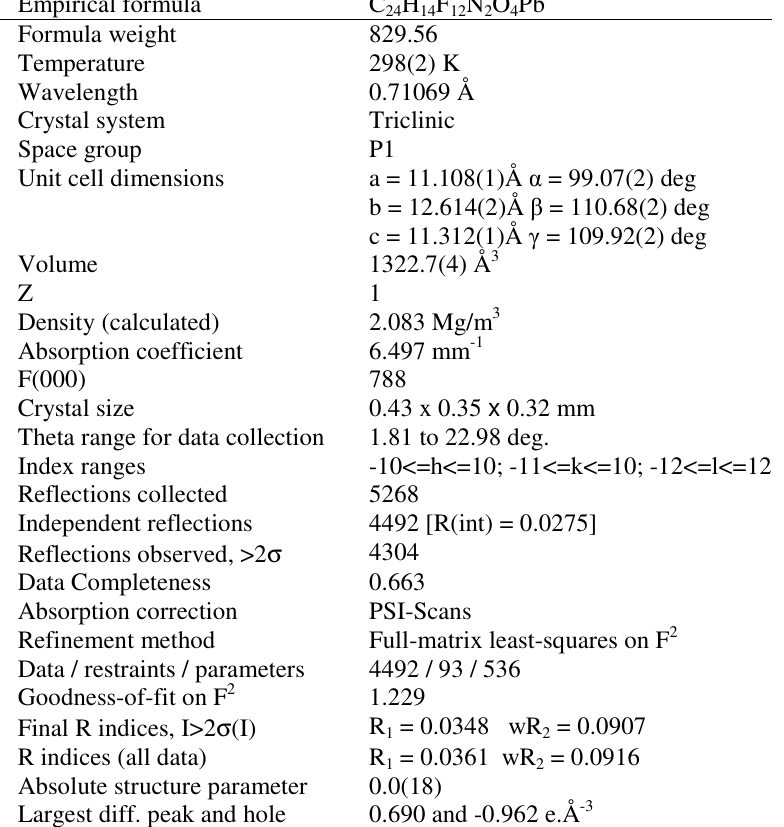
(dmp) (hfacac) ] . 2 2 4